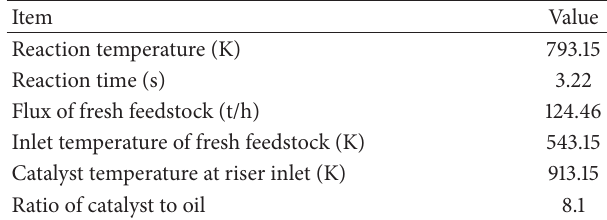
Figure 2: Mesh details. Table 1: Operating